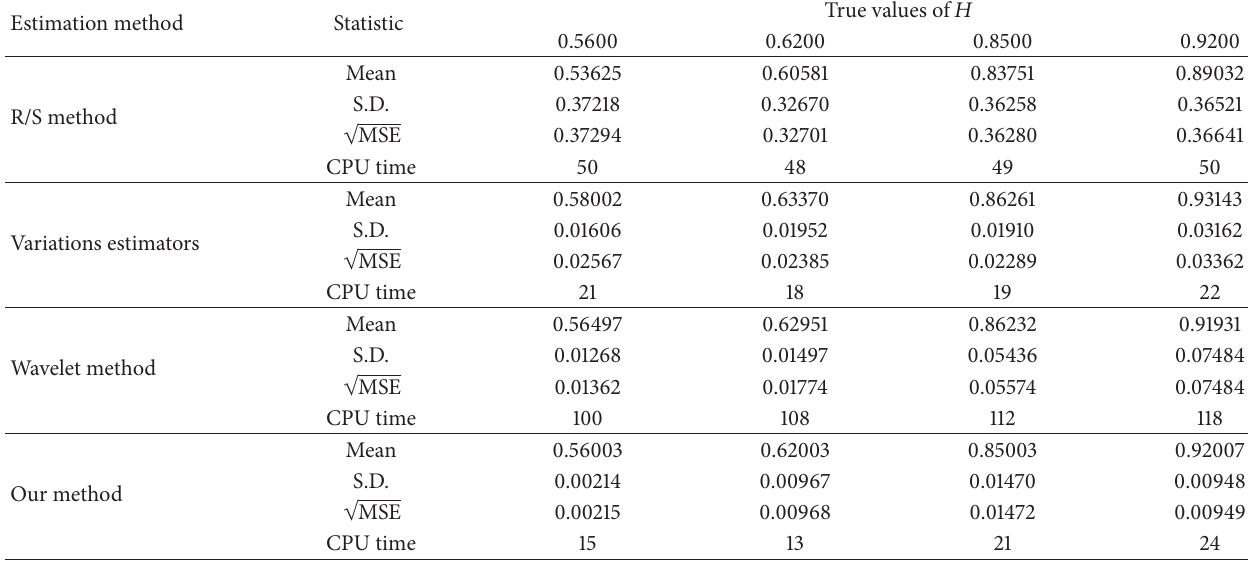
Table 2: The estimation results of comparative methods for sample size 𝑁 = 100